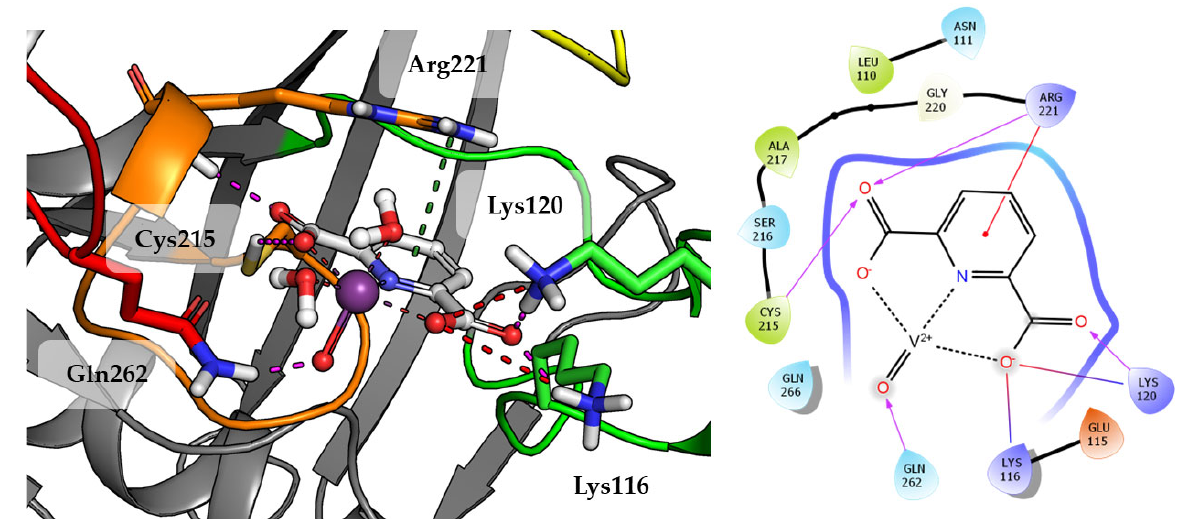
Figure 4. Docking result of Compound 1 to the PTP1B active site (PDB: 1ONZ). Left panel presents a studied compound as white sticks with protein represented by a gray cartoon. Significant loops are highlighted with separate colors; P ‐ loop in orange, WPD ‐ loop in yellow, E ‐ loop in green, and Q ‐ loop in red. The most important amino acids are represented as sticks with the same color code. Coordinate bonds are marked with thin dotted lines. Hydrogen bonds are marked in magenta, ionic interaction in red, aromatic π‐π or CH ‐π in green. Right panel presents 2D ligand interaction diagram.